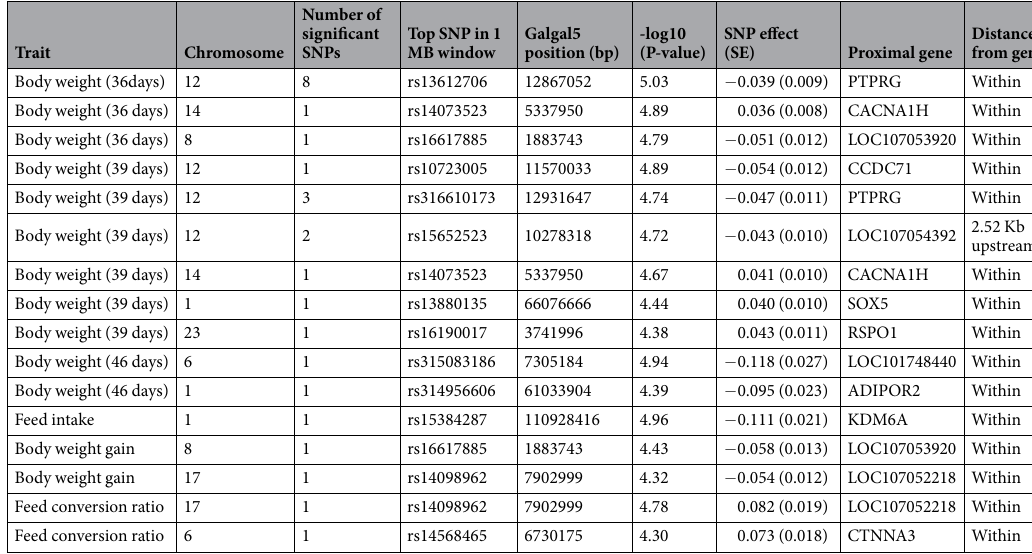
Table 1. Top SNPs associated with body weight and feed efficiency traits using mixed linear model